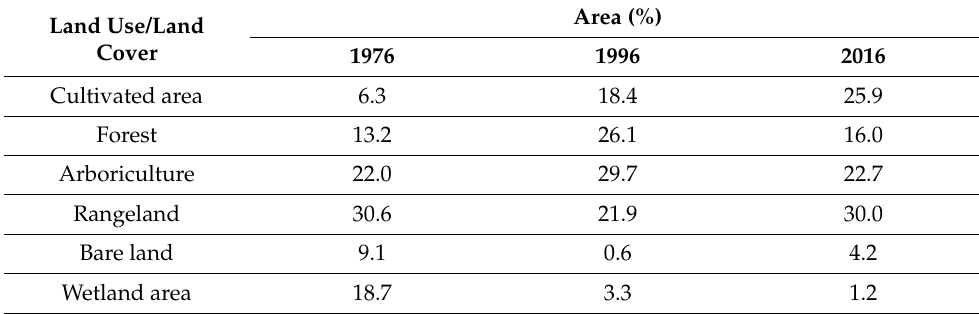
Table 4. Land use/land cover for the Merguellil Wadi Basin for 1976, 1996, and 2016.